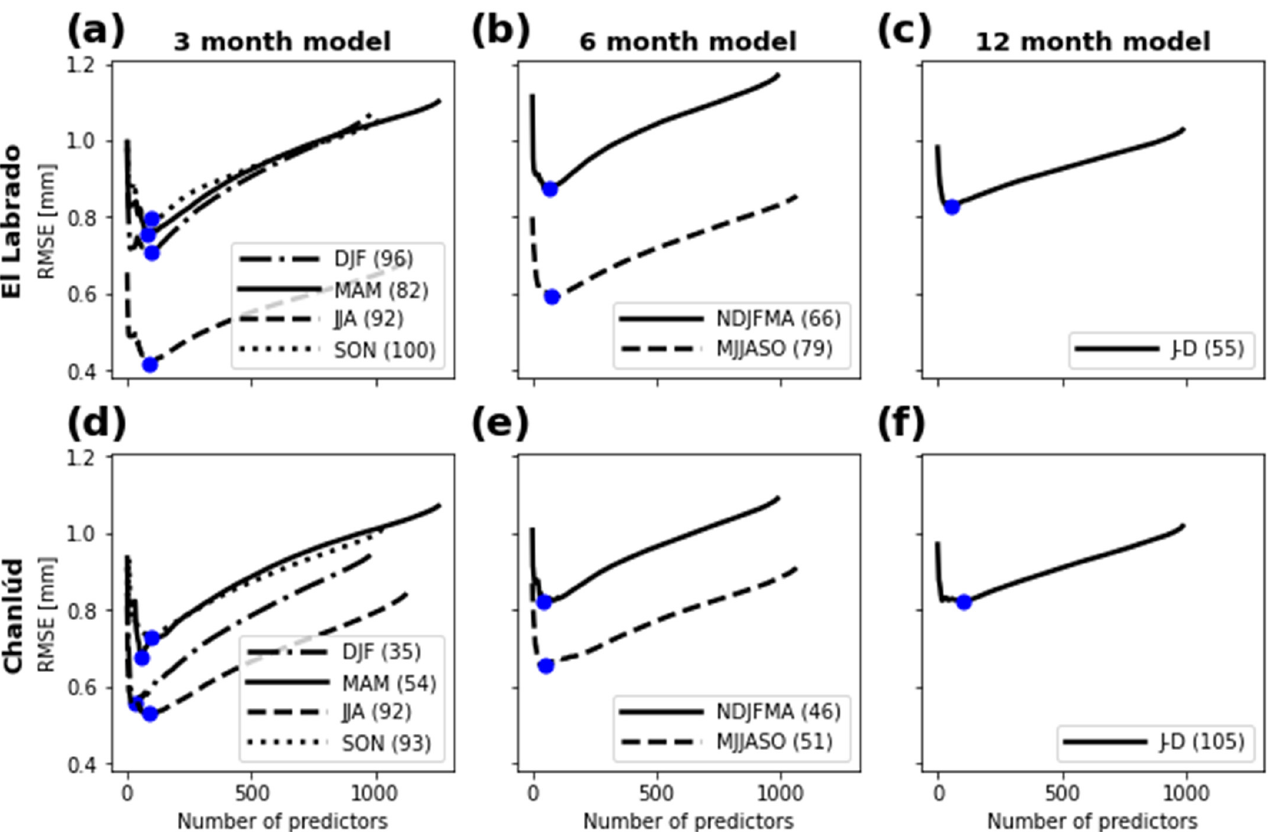
Figure 4. Sequential forward selection results: ( a – c ) models for El Labrado; ( d – f ) models for Chanlúd; ( a , d ) quarterly models; ( b , e ) semiannual models; ( c , f ) annual models. The dots show the best cross- validation performance, and the numbers in parentheses indicate the cardinality of the predictor subset with such best